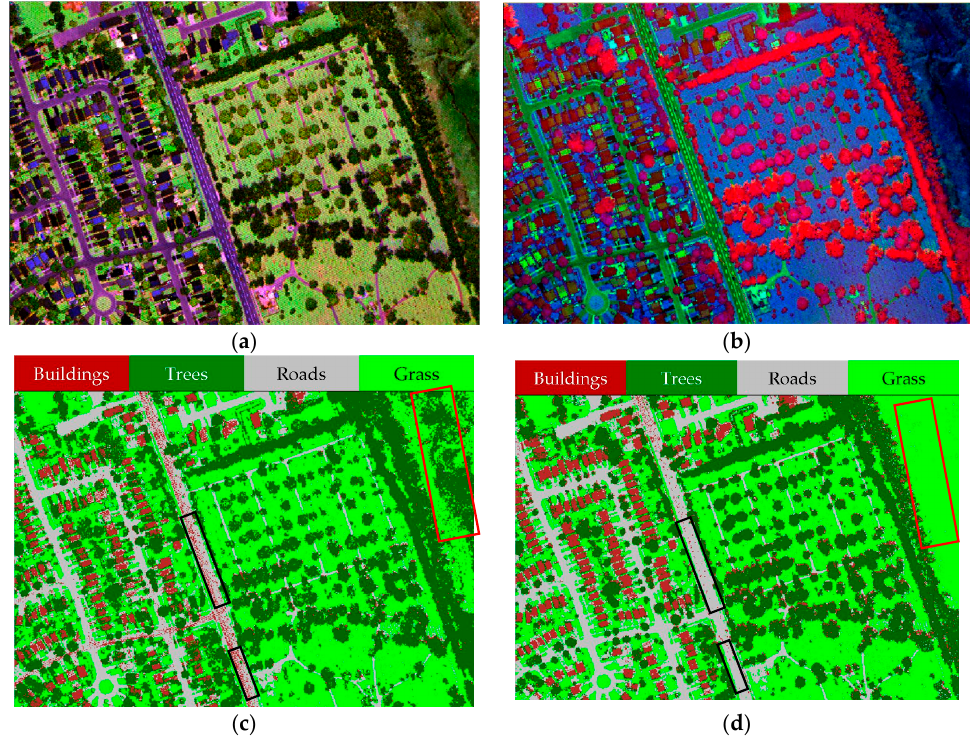
Figure 7. Combined and classified images: ( a ) Combined Intensity Bands (CIBs); ( b ) CIBs_DSM; ( c ) classified image from CIBs; ( d ) classified image from CIBs_DSM.